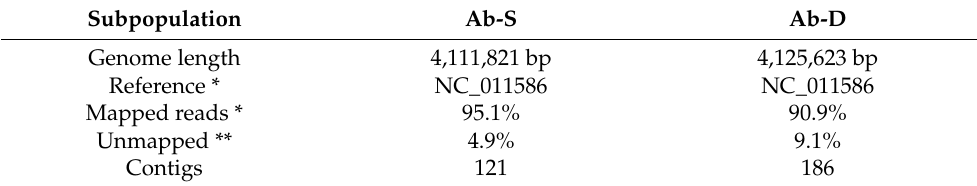
Table 1. Whole genome sequencing (WGS) of Ab-S and Ab-D subpopulations of A. baumannii . Subpopulation Ab-S Genome length Mapped reads * 95.1% 90.9% Contigs 121 186 * Complete genome sequences were searched against the NCBI bacteria database in order to determine the species.